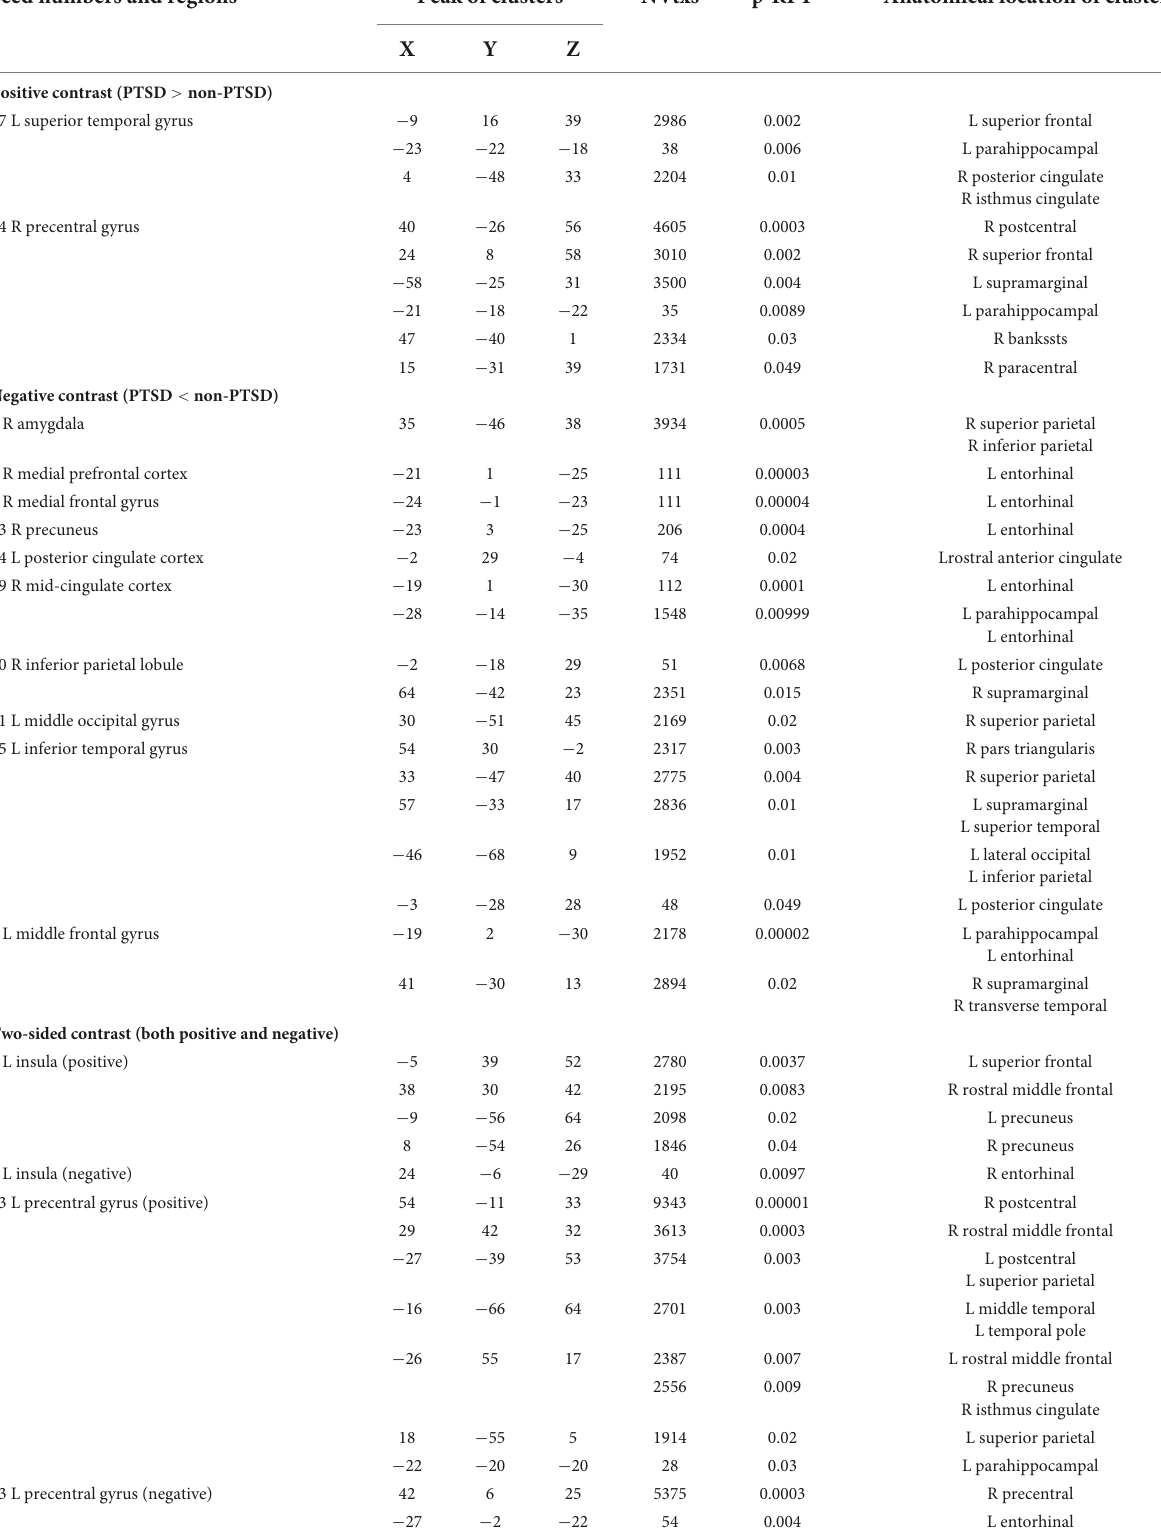
TABLE 3 Abnormal seed-based structural connectivity between post-traumatic stress disorder (PTSD) and non-PTSD (cluster p < 0.05, p-random-field-theory (RFT) corrected). Seed numbers and